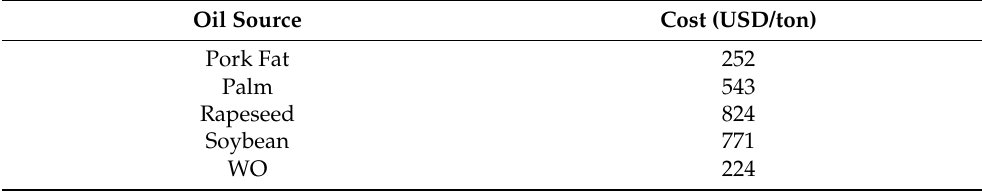
Table 4. Average International cost of some oil sources in USD/ton; data adapted from